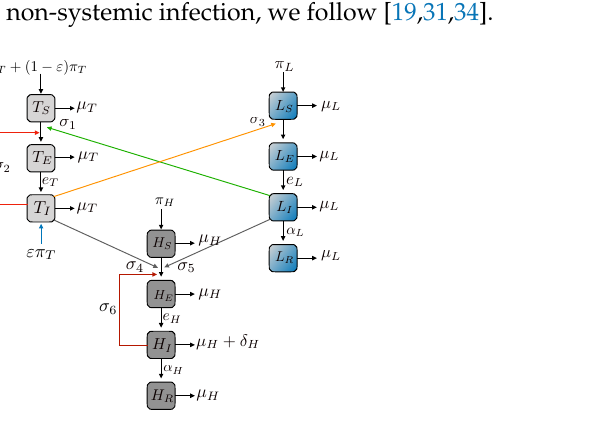
Figure 1. Infection process among the effective tick population (T), livestock (L), and humans (H). The infection process involves non-systemic transmission through co-feeding (red arrow), acquisition (green arrow), systemic transmission (orange arrow), influx of infected tick through transovarial transmission (blue arrow), demographic flux of individuals with different health status (black arrows) and CCHFV transmission to humans from the ticks and livestock (grey arrow) with the inclusion of human-to-human transmission (maroon